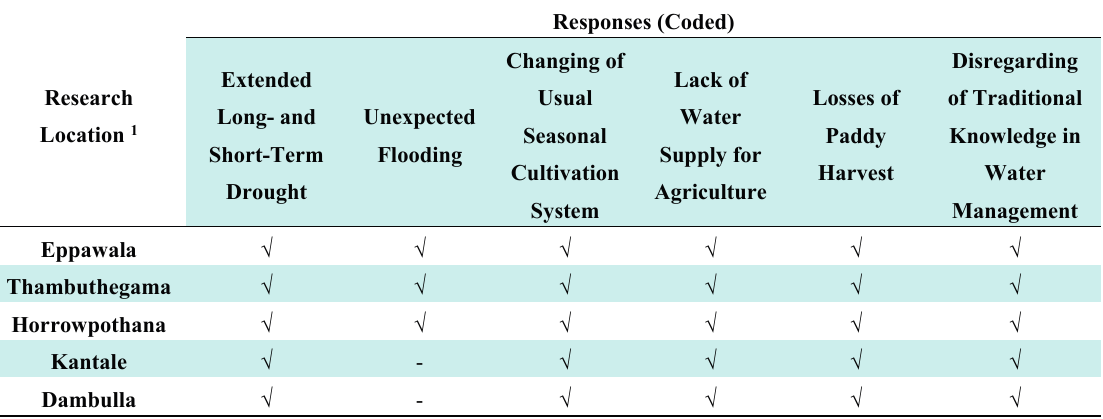
Table 2. The main responses (coded) in interviews and focus group